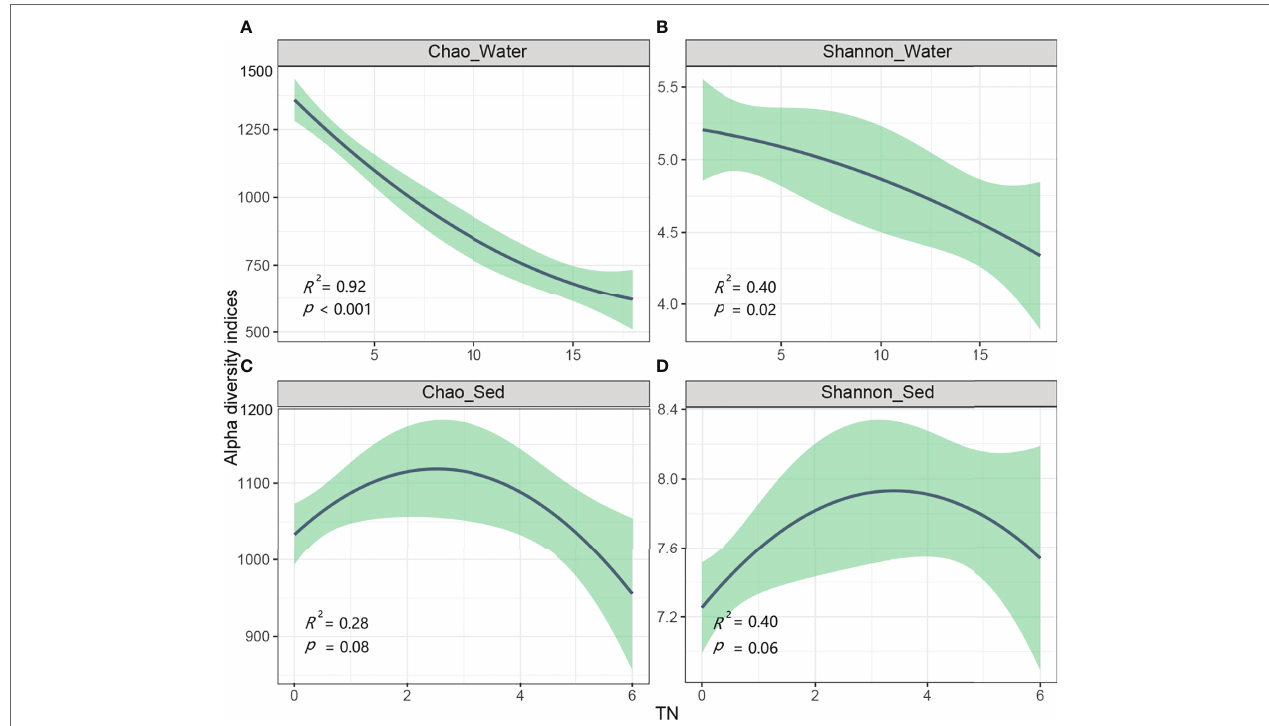
FIGURE 1 | Relationships of microbial richness and diversity against nitrogen concentration ( n